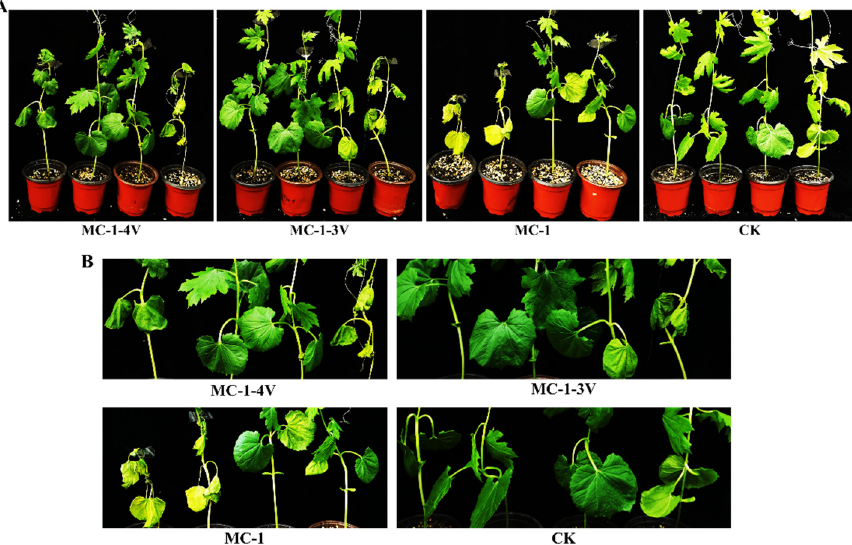
Figure 8. Virulence of F. oxysporum MC-1, MC-1-3V and MC-1-4V strains on bitter gourd plants: ( A ) Wilt symptoms on bitter gourd 15 days after inoculation with 10 mL spores (10 7 /mL) of F. oxysporum MC-1, MC-1-3V and MC-1-4V strains, Control plants (CK) were inoculated with water. ( B ) Enlarged images of (Figure 8A).